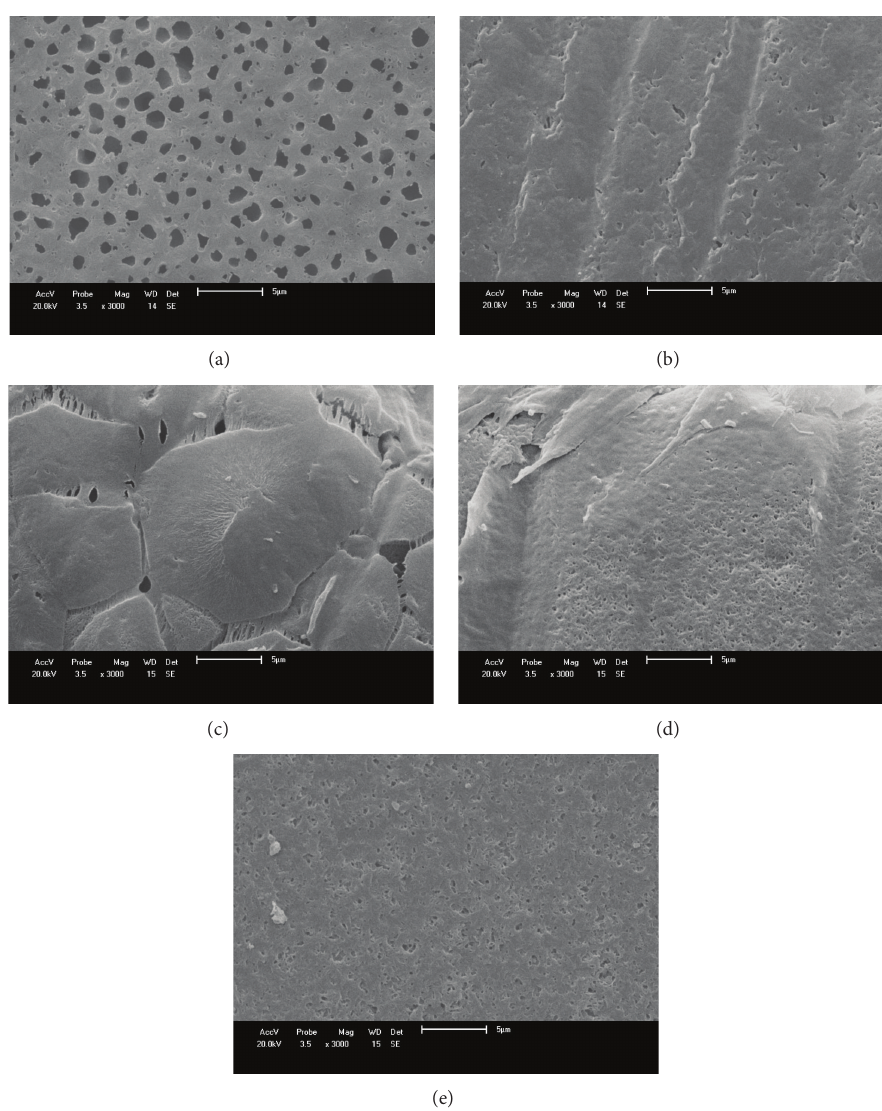
Figure 2: SEM images of the top surface of the membranes: (a) Pure PA6, (b) Homogenizer PA6, Extruder PA6, (c) Extruder PA6, (d) Homogenizer PA6 + 1%MMT, and (e) Extruder PA6 +